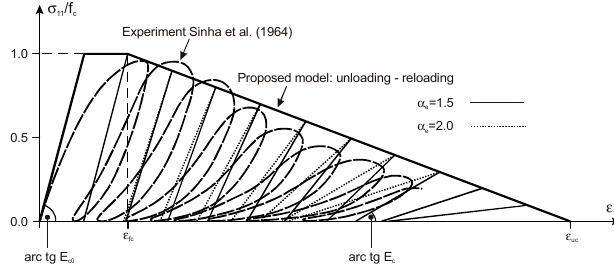
Figure 3. Degradation of modulus of elasticity.